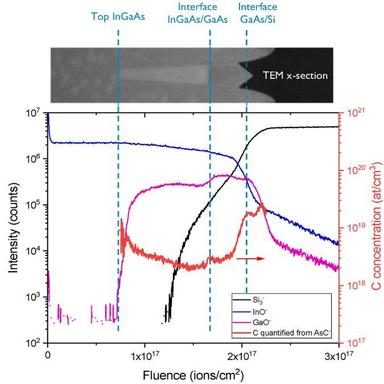
Orbitrap™-SIMS profile (quantified C using AsC− ) and cross-section TEM recorded on a 16 nm wide InGaAs/GaAs fin.